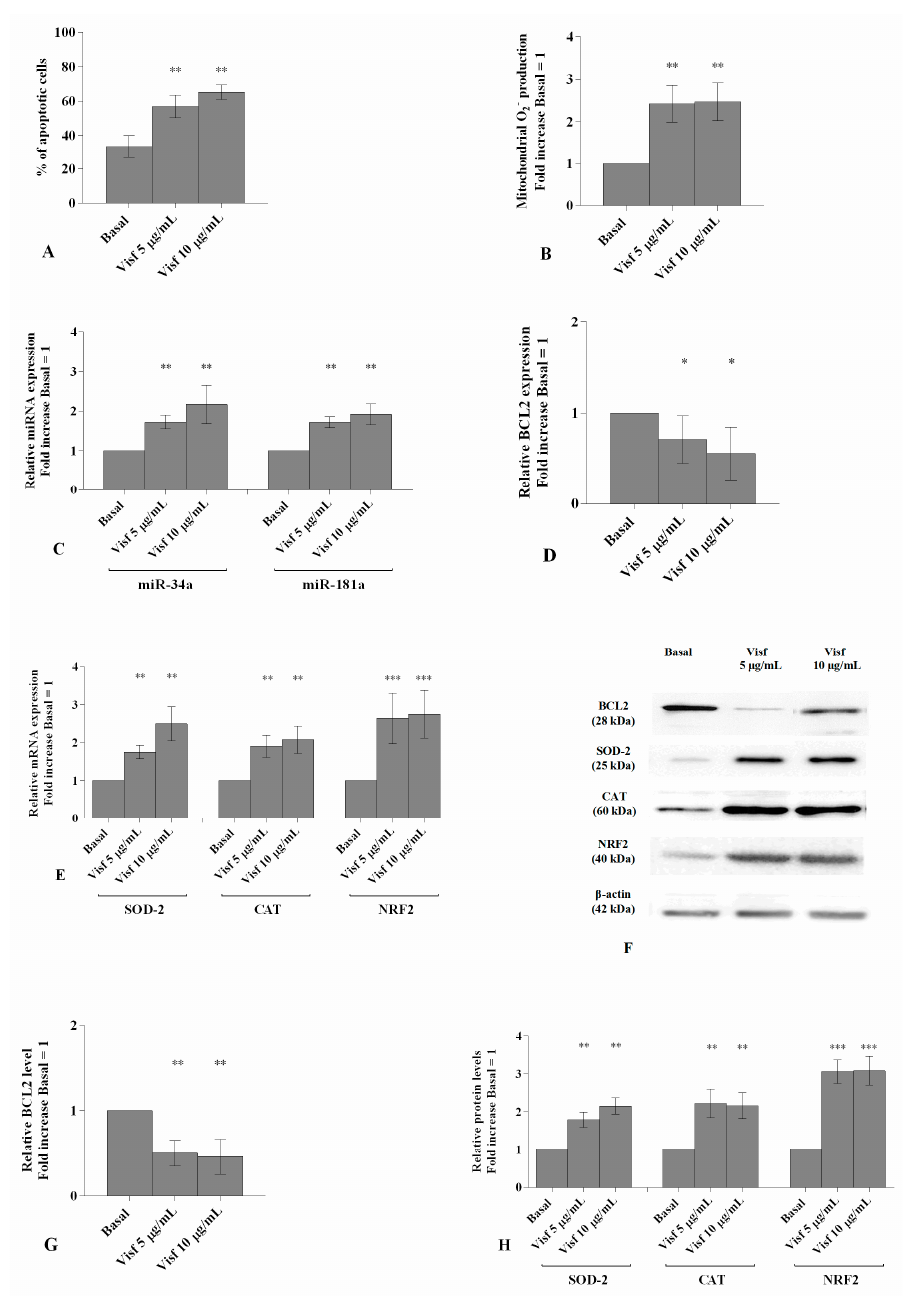
Figure 1. ( A ) Detection of apoptosis by flow cytometry analysis. Apoptosis was measured with Annexin Alexa fluor 488 assay. Data were expressed as percentage of positive cells for Annexin-V and propidium iodide (PI) in all the studied conditions. ( B ) The production levels of mitochondrial superoxide anion by flow cytometry analysis using MitoSox Red staining. ( C – E ) Expression levels of miR-34a, miR-181a, B-cell lymphoma (BCL2), superoxide dismutase (SOD-2), catalase (CAT), nuclear factor erythroid 2 like 2 (NRF2) by real-time PCR. ( F – H ) Representative immunoblotting image and densitometric analysis of BCL2, SOD-2, CAT, NRF2 protein levels by western blot. Human osteoarthritic (OA) chondrocytes were evaluated at basal condition and after 24 h of stimulus with visfatin (5 μ g/mL and 10 μ g/mL). The production of superoxide anion, the gene expression and the protein levels were referenced to the ratio of the value of interest and basal condition (Basal, cells without treatment). The value of basal condition was reported equal to 1. Data were expressed as mean ± SD of triplicate values. * p < 0.05, ** p < 0.01, *** p < 0.001 versus basal condition. Visf =